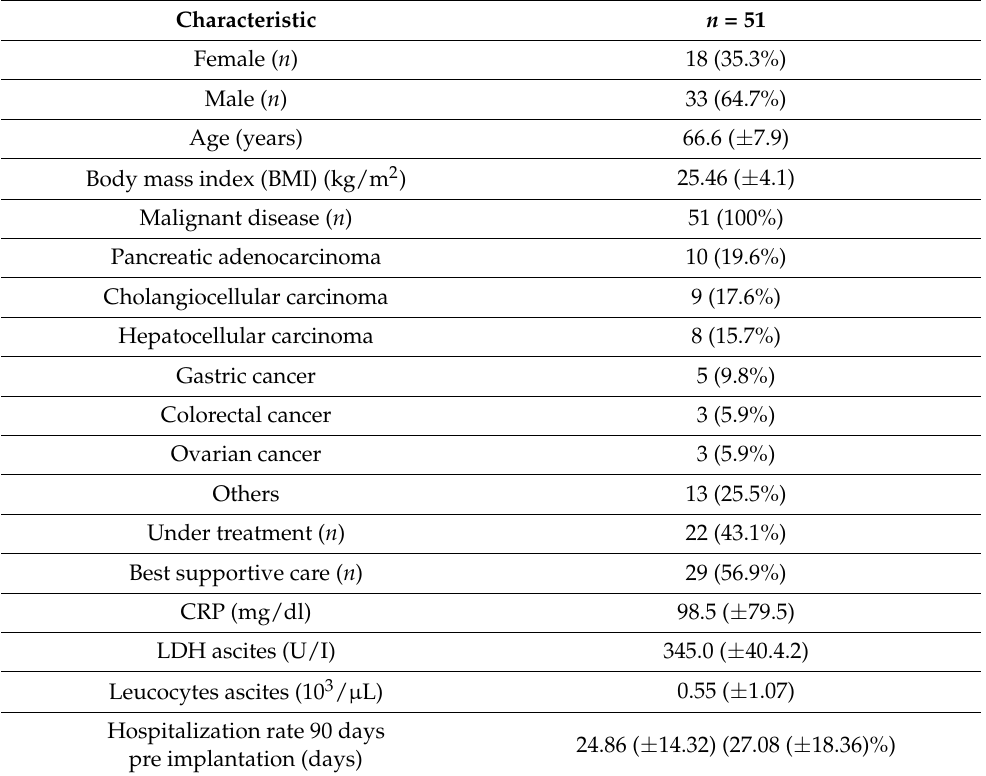
Table 1. Characteristics of the patients. CRP: C-reactive protein, LDH: lactate dehydrogenase; BMI: body mass